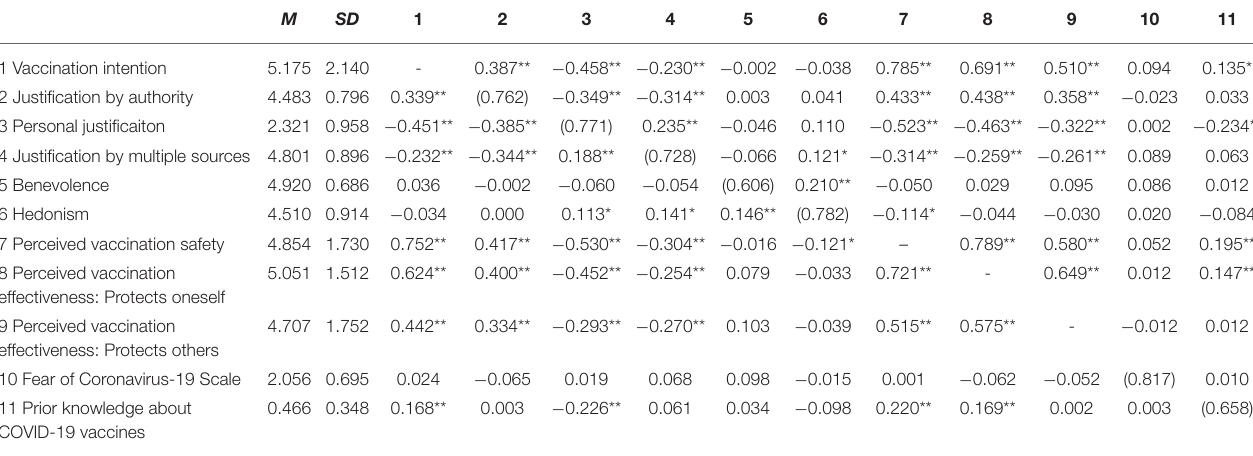
TABLE 1 | Descriptive statistics and intercorrelations of the main study